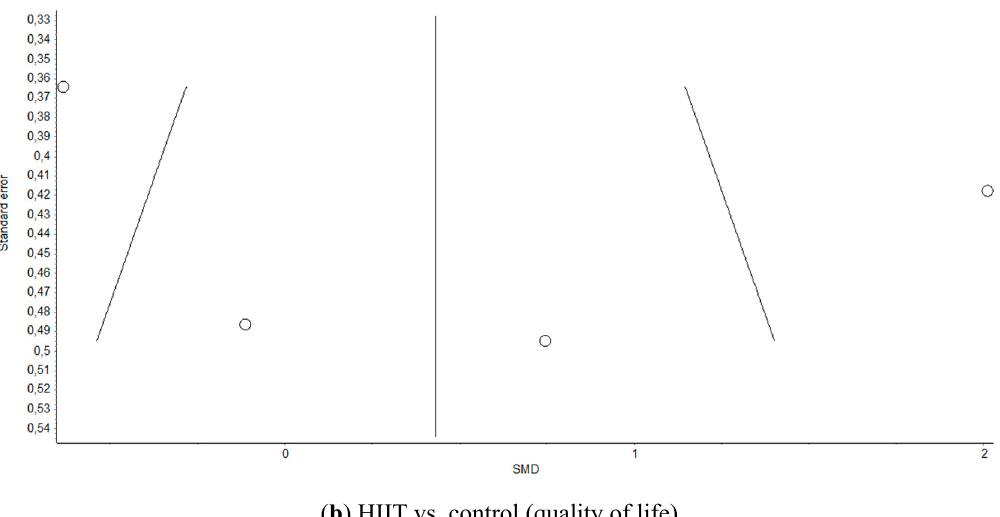
Figure A3. Synthesis Funnel and Doi plot (LFK index) for disability and quality-of-life variables to assess the presence of publication bias.